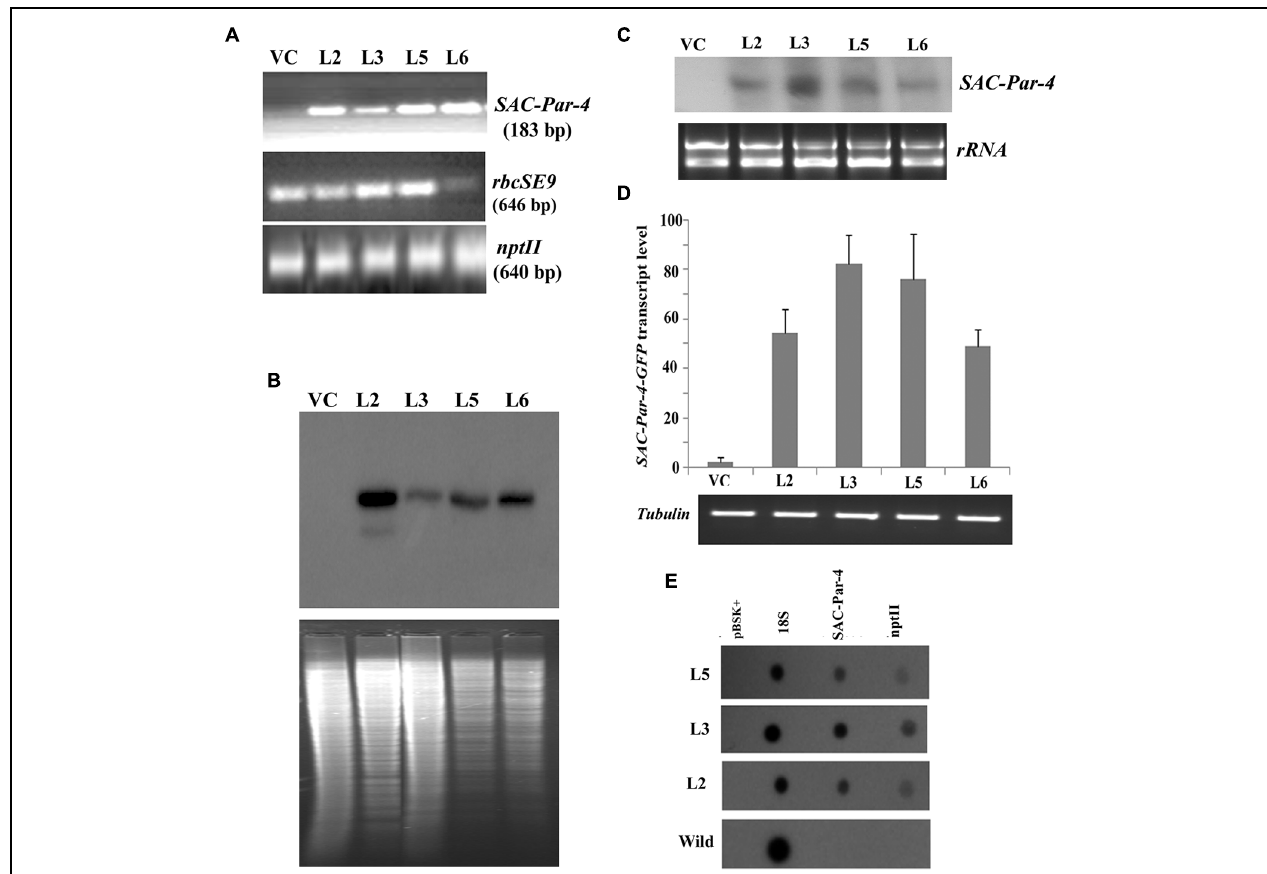
FIGURE 3 | Transgenic analyses. (A) PCR amplification of different genes, viz. SAC-Par-4 (i); rbcSE9 (ii) and npt II (iii) from transgenic lines VC, L2, L3, L5, and L6 on 1.5% agarose gel; (B) Southern blot analysis to investigate SAC-Par-4 gene insertion in transgenic plant lines VC, L2, L3, L5, and L6. Underneath is the agarose gel picture showing Xho I digested genomic DNA (10 μ g) of T 2 generation of four transgenic (L2, L3, L5, and L6 of SAC-Par-4-GFP) and vector control lines (prior blotting); (C) Northern blot analysis of SAC-Par-4 mRNA expression in transgenic plants VC, L2, L3, L5, and L6. Underneath is an ethidium bromide-stained gel showing rRNA quality; (D) Real-time analysis of SAC-Par-4 transcripts in VC, L2, L3, L5, and L6 lines. The data were normalized by tubulin transcripts. The data shown are mean values from three independent experiments. Bars indicate the standard errors of means; (E) Nuclear run-on assay of SAC-Par-4 transcripts. Dot blots were hybridized to 32 P-labeled nascent transcripts from wild-type plant and transgenic lines L2, L3, and L5 which were synthesized by run-on transcription. pBSK plasmid (1 μ g) and 18S ribosomal DNA (0.5 μ g) were used as